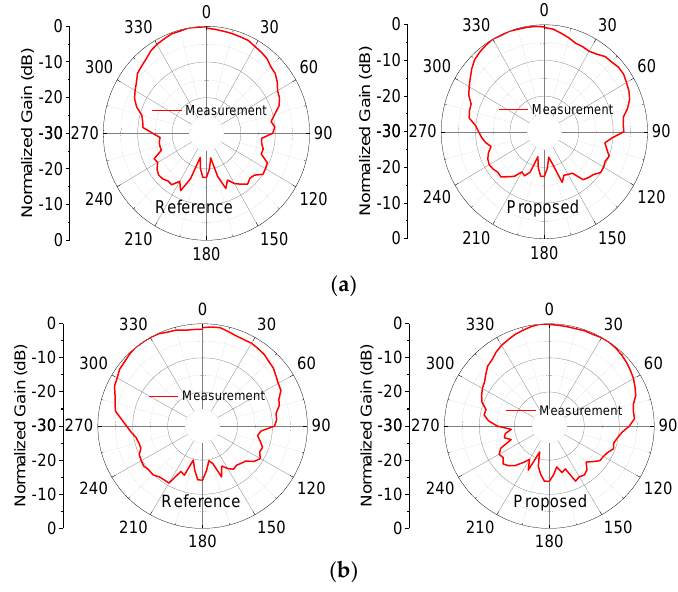
Figure 10. Measured radiation patterns at center frequency. ( a ) xoz − plane. ( b ) yoz − plane. signs. The performance of the proposed antenna is competitive compared to other antenna makes the design simple and compact. Table 2. Comparison with other decoupling methods.